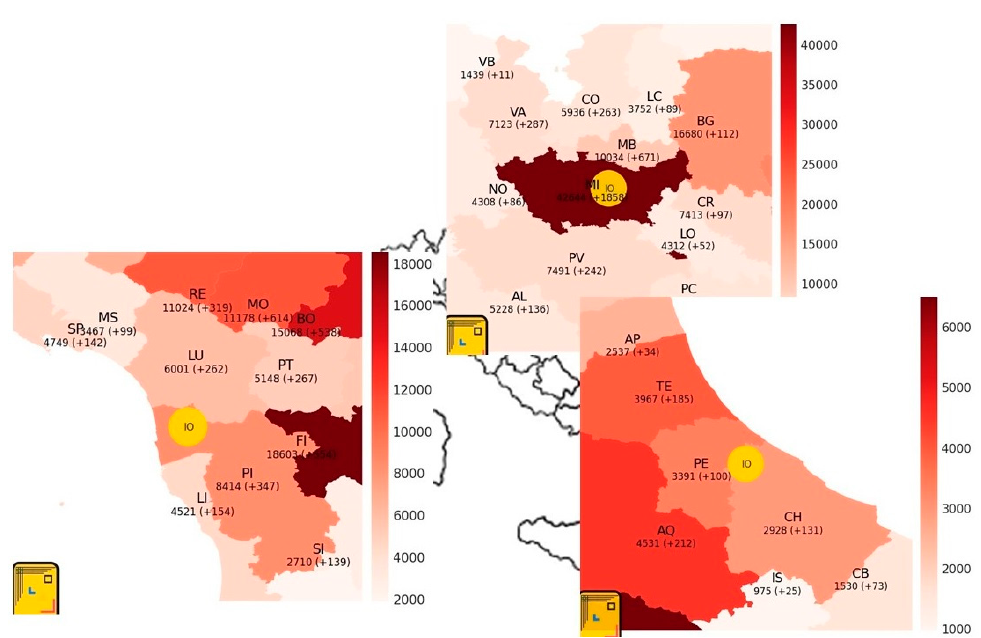
Figure 5. Dress-COV: daily visualization of contagions, in terms of total numbers and daily increase. Example of views from different regions.